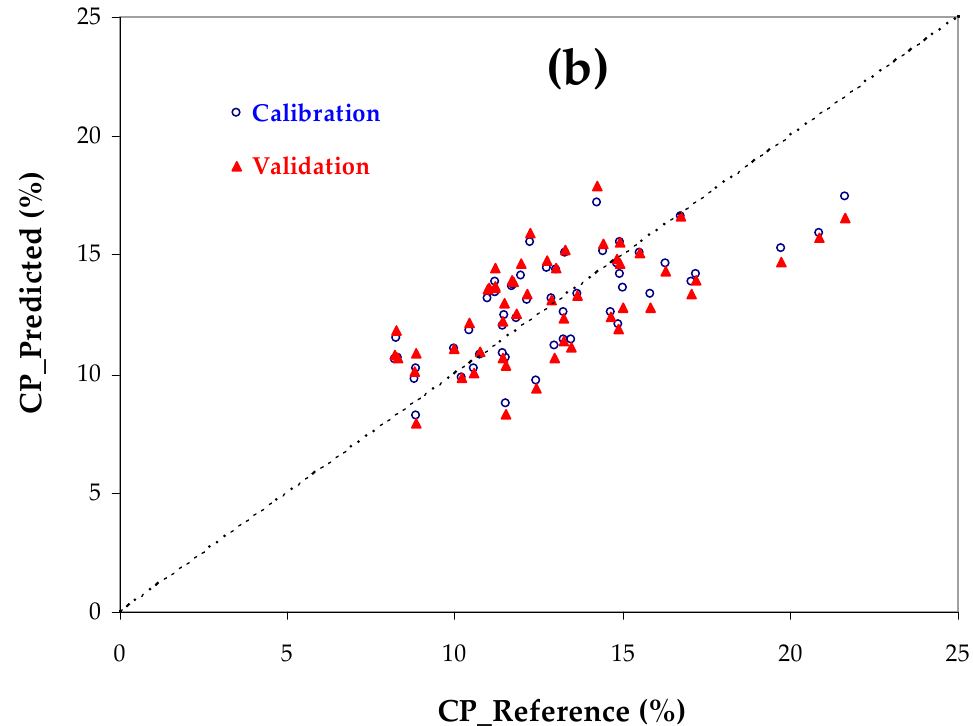
Figure 5. Plot of the calibration and internal validation phases between reference and predict values of fibre (NDF, a ) and crude protein (CP, b ).